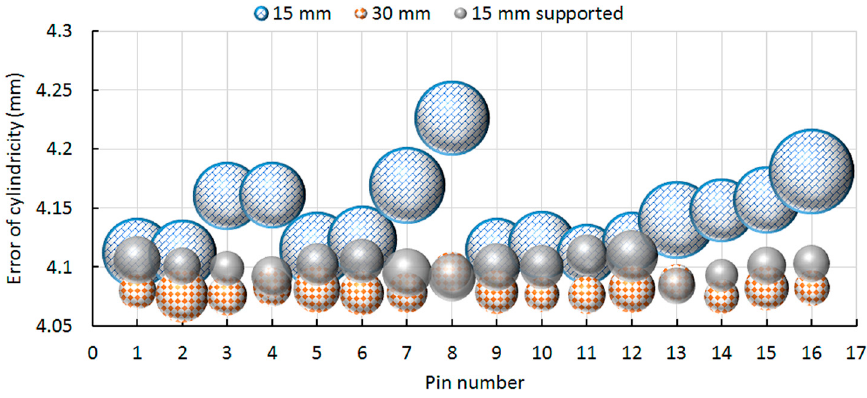
Figure 5. Error of cylindricity for the 16 pins allocated on top of the NIST part.